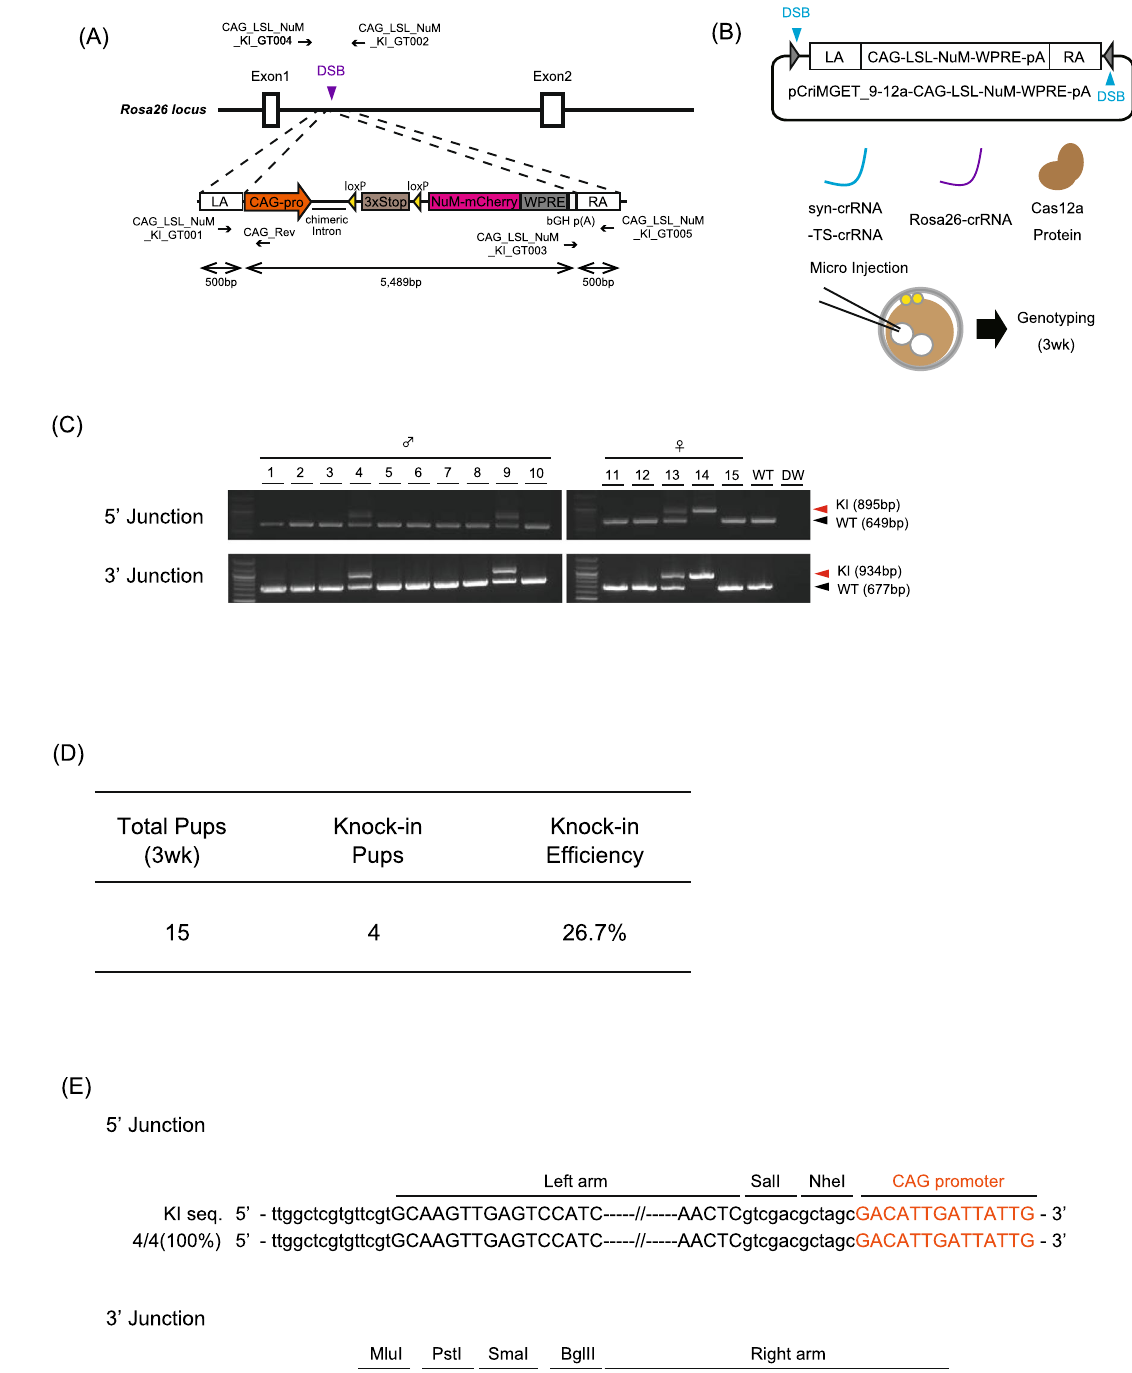
Figure 4. Generation of Rosa26 CAG-LSL-NuM-mCherry knock-in mice by the pCriMGET_9-12a/CRISPR-Cas12a system. ( A ) pCriMGET_9-12a/CRISPR-Cas12a-mediated knock-in of the donor cassette ( CAG-LSL-NuM- mCherry-WPRE-pA ) at the Rosa26 locus. ( B ) Strategy used to generate the Rosa26 CAG-LSL-NuM-mCherry knock-in mice. ( C ) Genotyping PCR for Rosa26 CAG-LSL-NuM-mCherry knock-in F 0 pups at 3 weeks old. PCR was performed